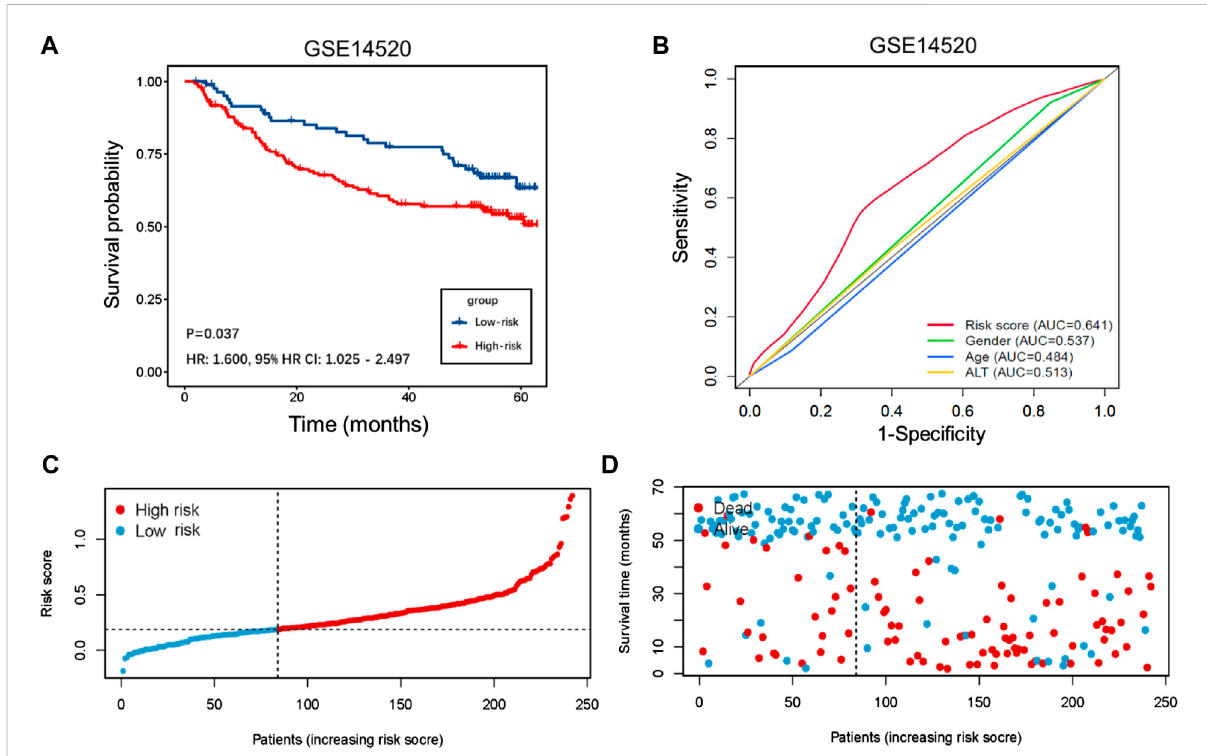
FIGURE 5 ValidationofGSE14520cohort. (A) K – McurvefortheGSE14520cohort.Patientsinthelow-riskgrouprepresentedabetterOS. (B) Comparison of the 3 years ’ ROC curve with other clinical characteristics. (C) Distribution of risk score of liver cancer patients in the GSE14520 cohort. (D) Distribution of survival status of liver cancer patients in the GSE14520